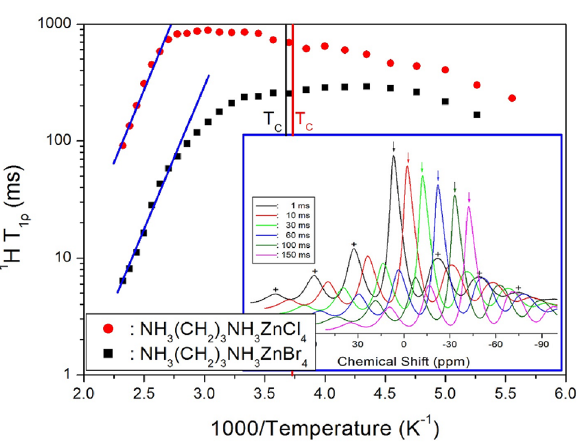
Figure 6. MAS 1 H NMR spin–lattice relaxation times (T 1ρ ) of [NH 3 (CH 2 ) 3 NH 3 ]ZnCl 4 and [NH 3 (CH 2 ) 3 NH 3 ] ZnBr 4 as a function of inverse temperature (Inset: recovery curves for delay times of MAS 1 H NMR spectrum in [NH 3 (CH 2 ) 3 NH 3 ]ZnCl 4 at 300